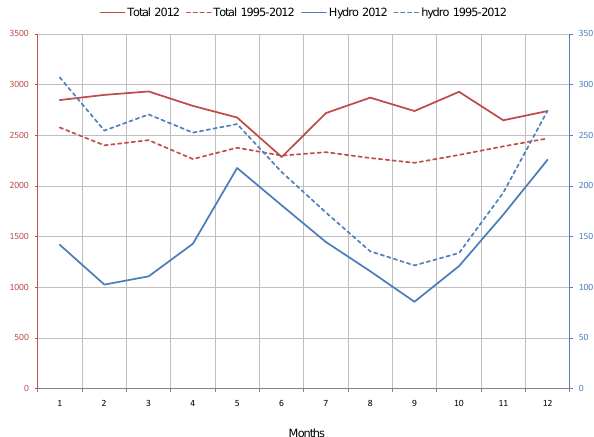
Figure 14. Monthly energy production in Spain (units: ktep). The right y axis is for hydropower and the left y axis is for the total energy